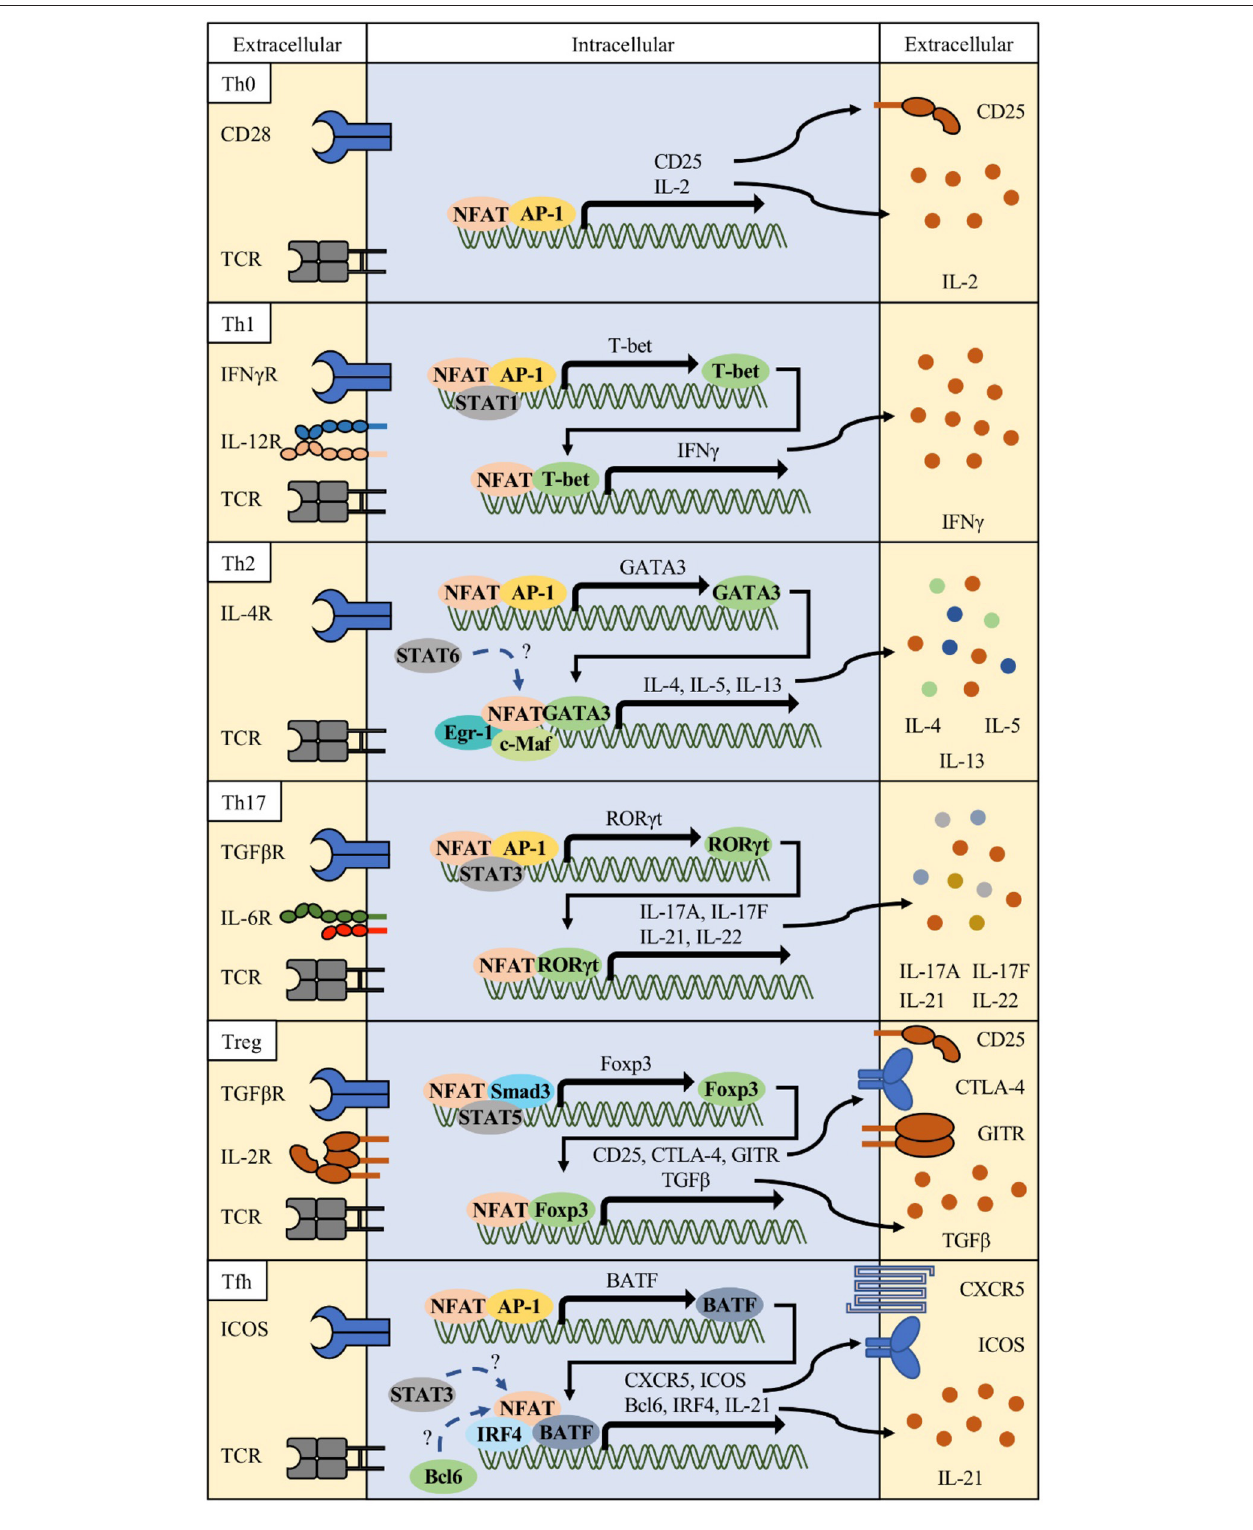
FIGURE 2 | Various combinations of NFAT and interacting partner proteins in T helper cells. Differentiation of each Th cell is initiated by activation of T cell receptor (TCR), costimulatory receptor signals (e.g., CD28 or ICOS), and specific lineage determining cytokine signals. These signals orchestrate to induce the NFAT/AP-1 complex to express lineage-related transcription factors such as T-bet for Th1, GATA3 for Th2, ROR γ t for Th17, and BATF for follicular helper T (Tfh) cells. In combination with these transcription factors, NFAT/partner protein complexes determine their lineage differentiation and functional characteristics (surface receptors and cytokine